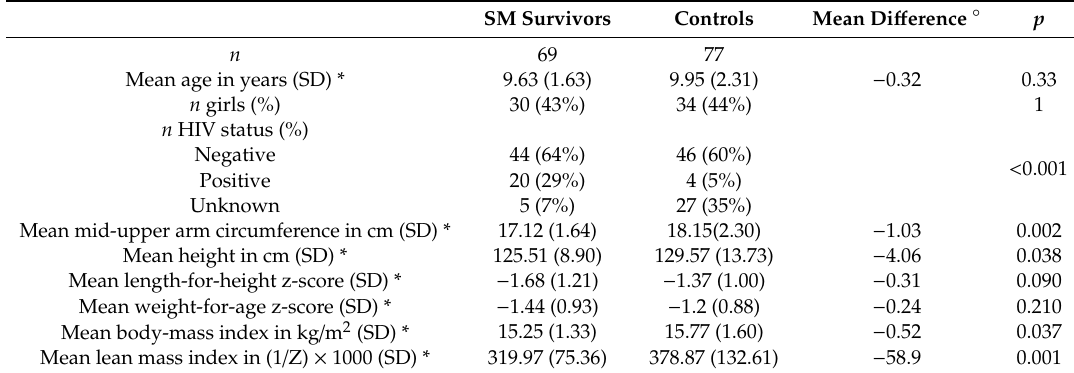
Figure 1. Recruitment flow diagram. Table 1. Characteristics of study participants in this secondary metabolomics analysis.